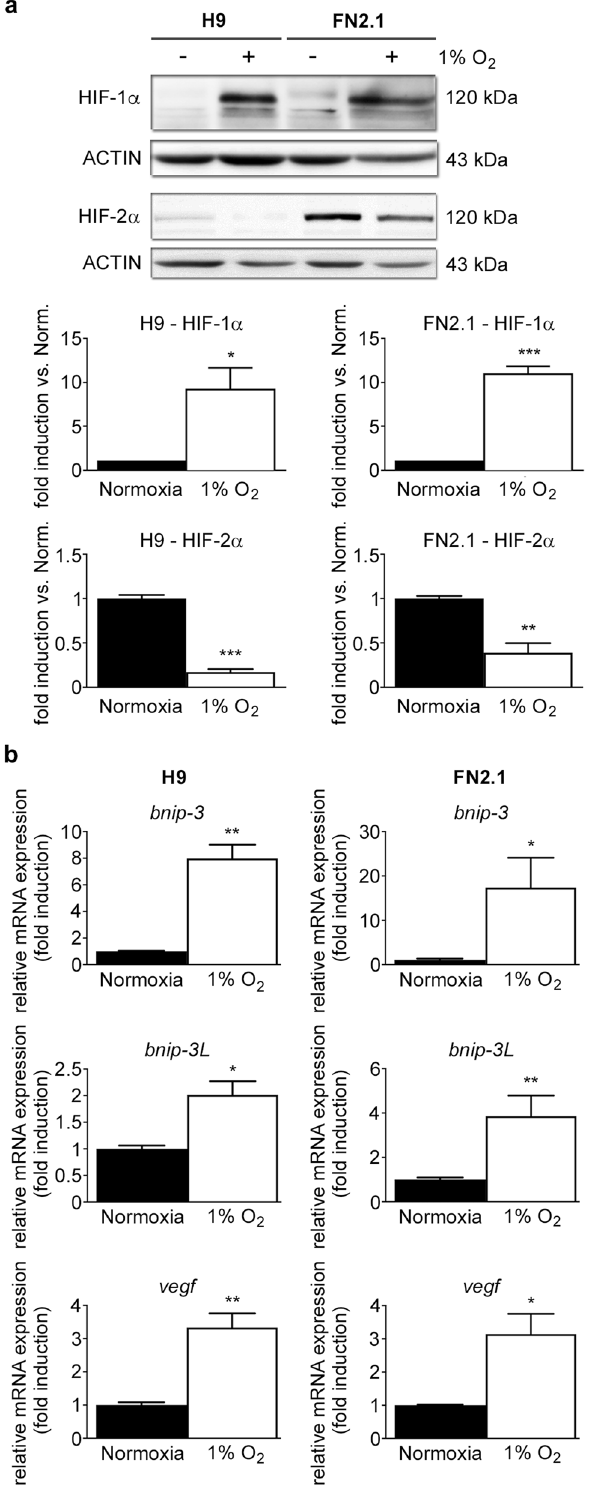
Figure 1. HIF-1α and HIF-2α protein expression levels upon 1% O 2 incubation. ( a ) HIF-1α and HIF-2α protein expression levels were quantified by western blot in H9 hESCs and FN2.1 hiPSCs upon 24 h of 1% O 2 incubation. ACTIN was used as loading control. Representative blots of three independent experiments are shown (full-length or original western blot images are presented in Supplementary Fig. S8 and S9). Bar graphs represent the densitometric quantification of bands. Norm.: normoxia. Data are expressed as means + SEM fold induction relative to normoxia (arbitrarily set as 1) and Statistical analysis was done by Student’s t-test, (*) p < 0.05 and (***) p < 0.001 versus normoxia. ( b ) Analysis of mRNA expression levels of BNIP-3 , BNIP-3L, and VEGF quantified by RT-qPCR in FN2.1 and H9 hPSCs at 24 h post 1% O 2 treatment. RPL7 mRNA expression levels were used as normalizer. Graphs show mean + SEM mRNA fold induction relative to normoxia control cells (arbitrarily set as 1) of at least three independent experiments. Statistical analysis was done by Student’s t-test, (*) p < 0.05, (**) p < 0.01 and (***) p < 0.001 versus